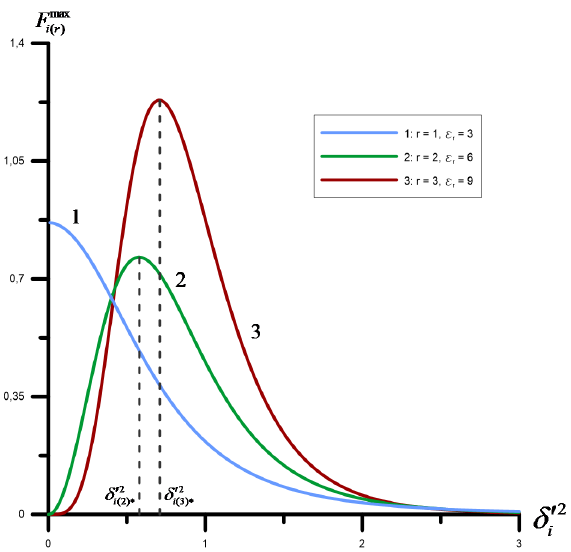
Figure 7. The dependency of the F max the initial electron energies are considerable (45) ( ε 1 = 10 3 ). The curves 1, 2, 3 outline the resonances.